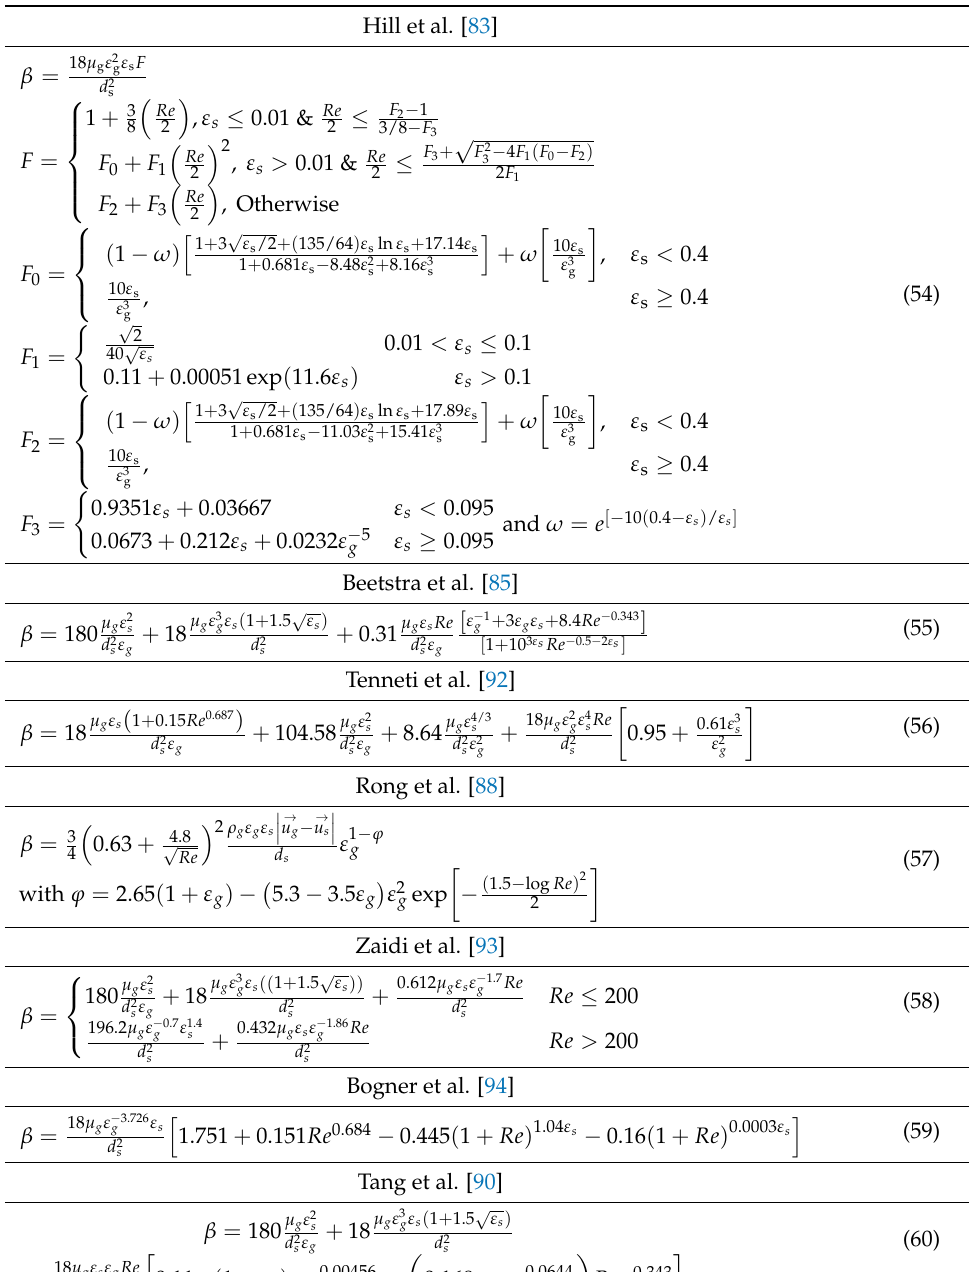
Table 13. DNS-based drag